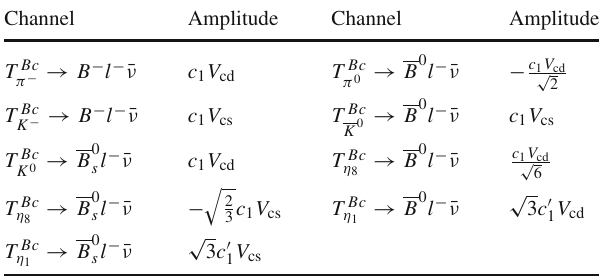
introduce new Feynman diagrams, but these Feynman diagrams have the same SU(3) topology, and thus can be classified as the same topo- logical diagram